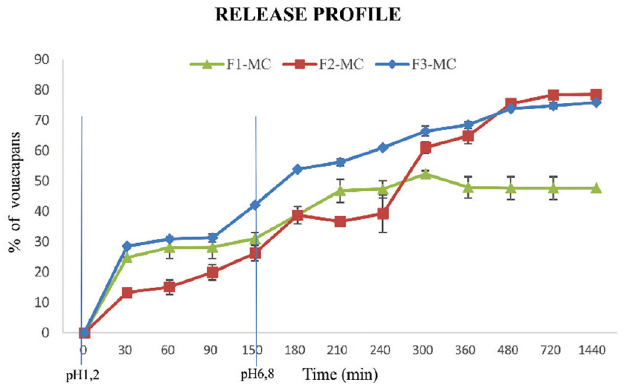
FIGURE 7 - In vitro release profile of FHPp-loaded